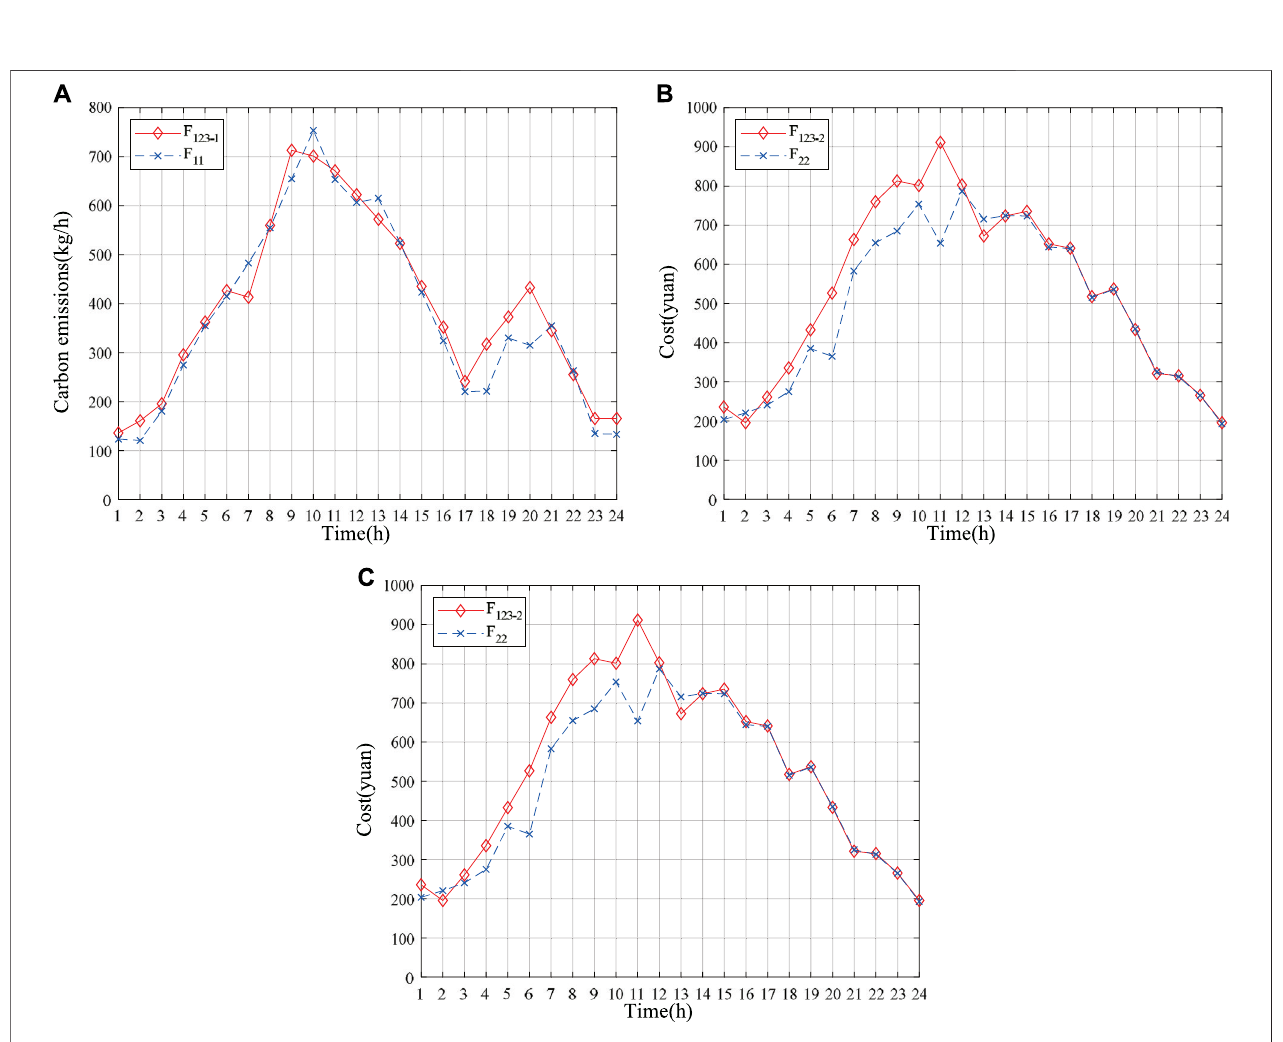
FIGURE7| Periodby period analysisofsingle objective and multi-objective optimization results. (A) Comparison ofenvironmental protectionobjectives byperiod. (B) Period by period comparison of economic objectives. (C) Period by period comparison of energy ef fi ciency objectives.